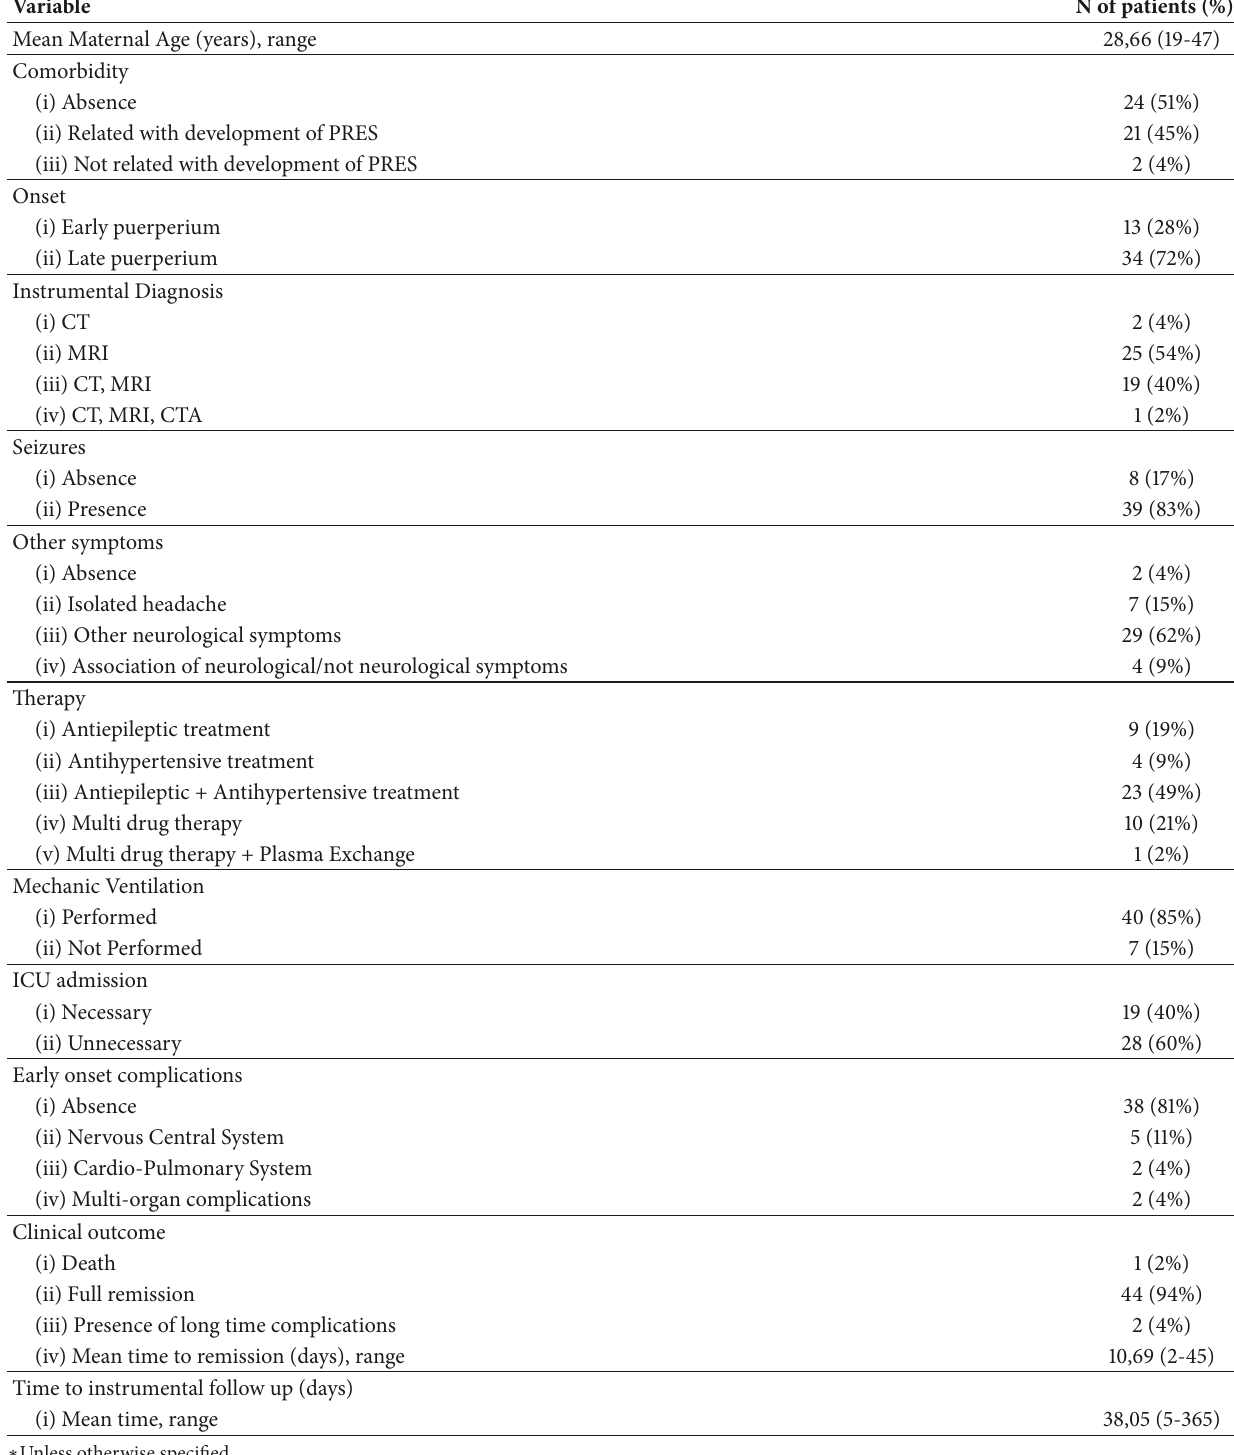
Table 2: Summary of patients’ characteristics, clinical data, and